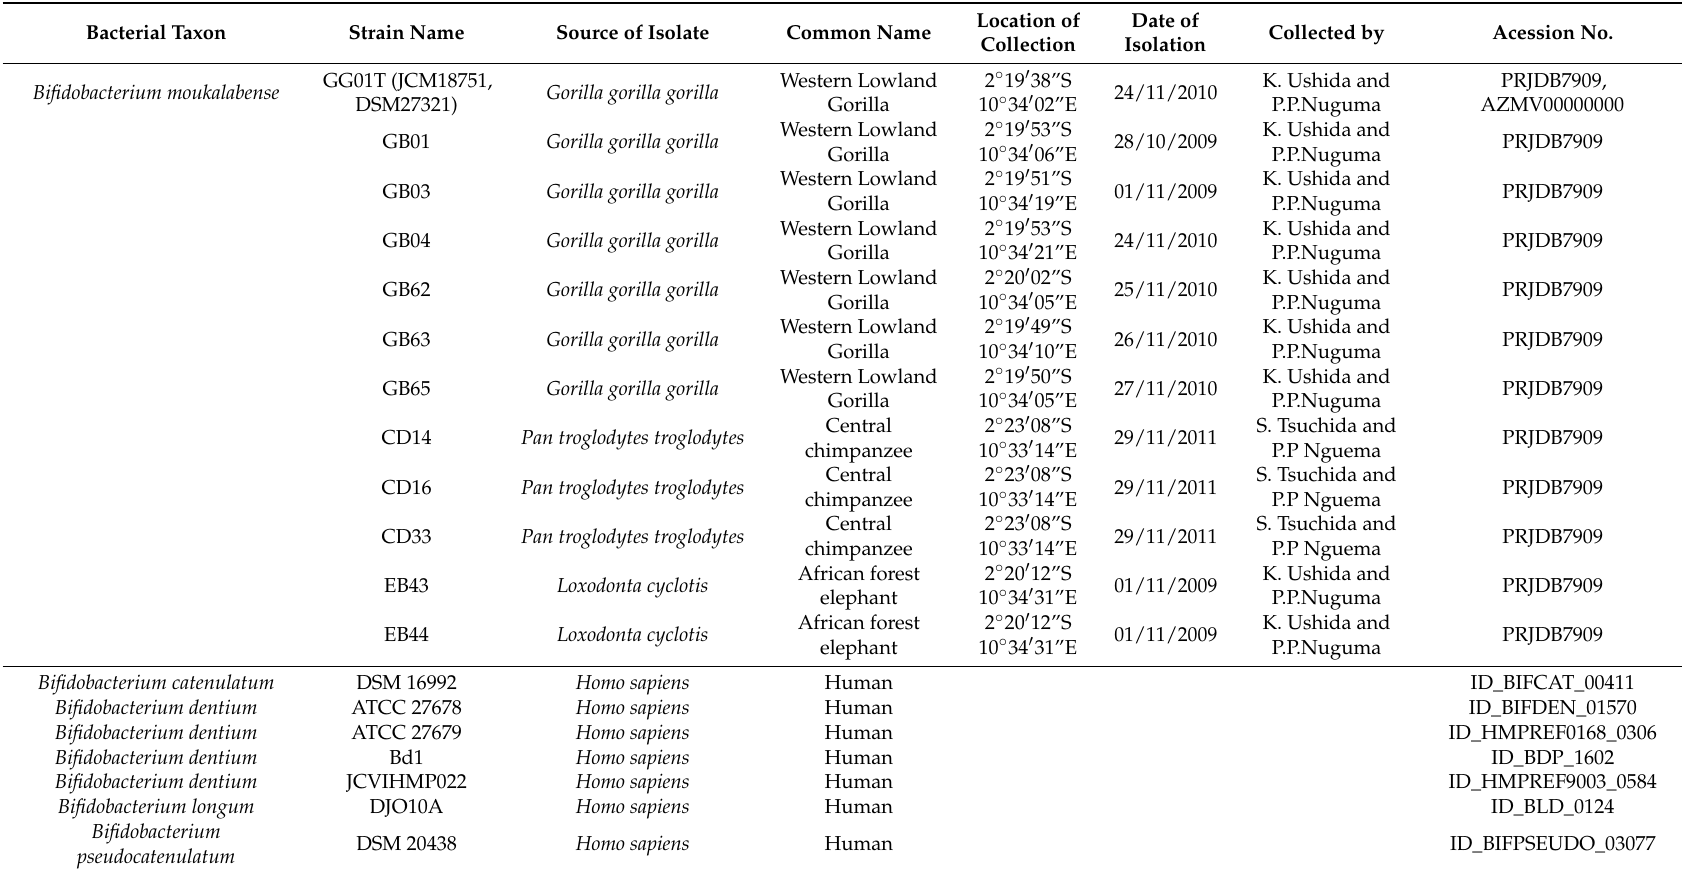
Table 1. Bifidobacterium strains in this